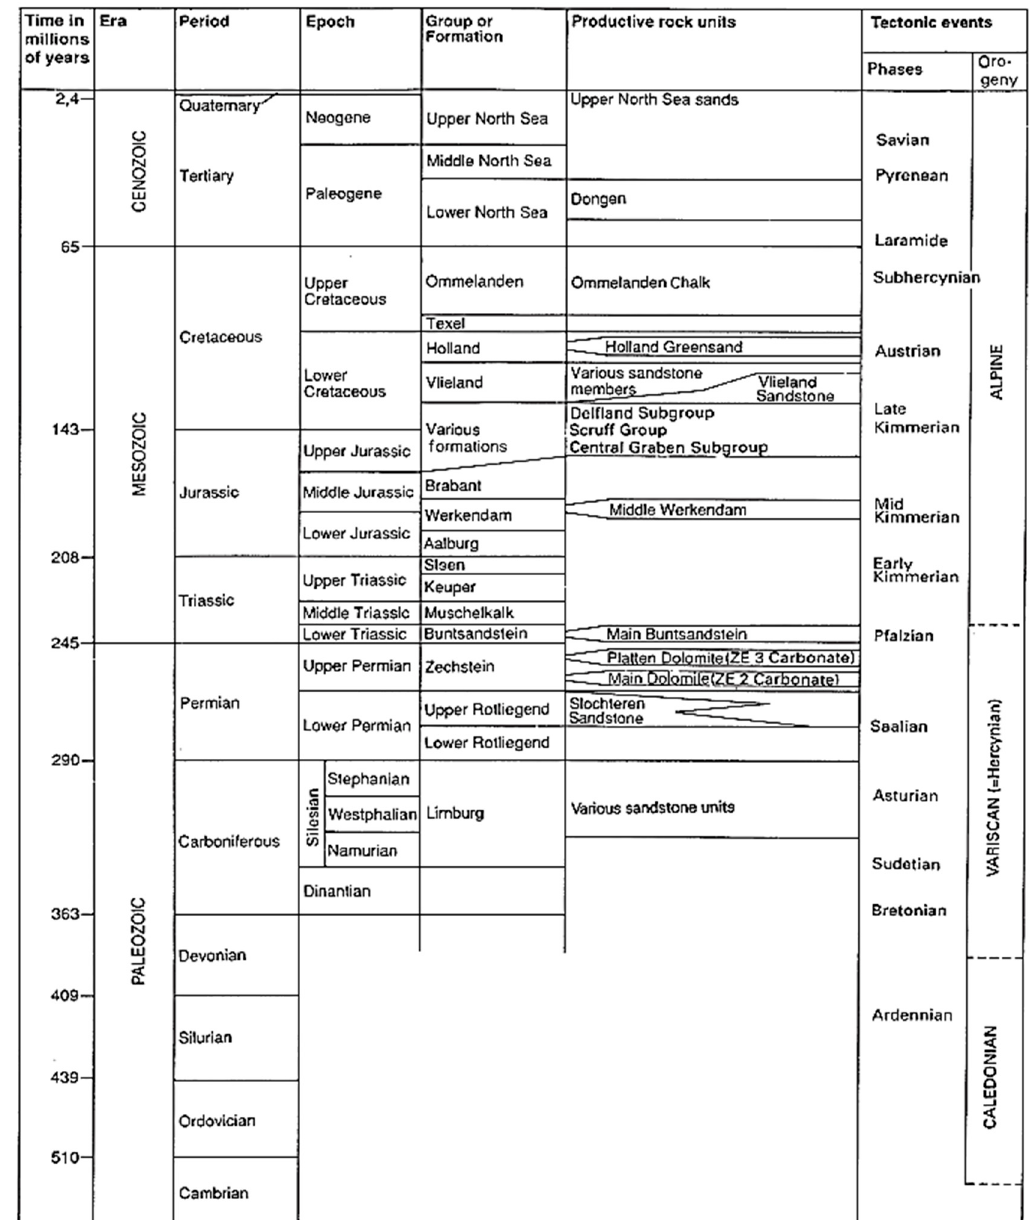
Figure 6. Detailed stratigraphy and tectonic events in the North Sea Basin [40].